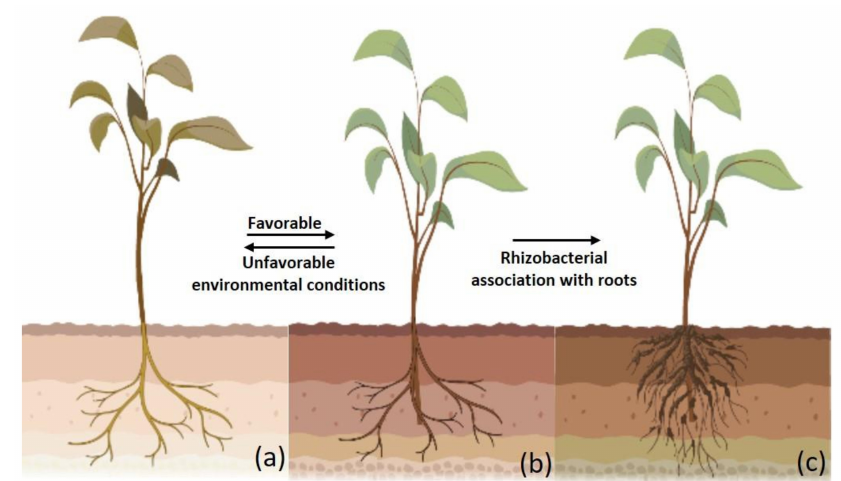
Figure 1. Plant growth under different environmental conditions: ( a ) Progression of climatic condi- tions from favorable to unfavorable that affects overall performance of the plant, ( b ) Plant growth under normal conditions, and ( c ) Plant-microbiome interactions that affect overall performance of the